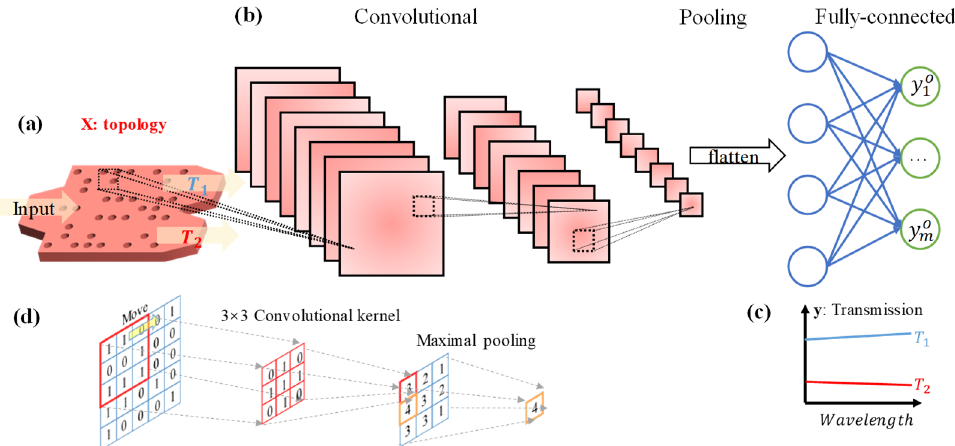
Figure 7. Training of a CNN to predict the efficiency of a power splitter based on QR-code like structure. ( a ) Initial QR-code structure with one input waveguide and two output waveguides. ( b ) Schematic process of CNN. ( c ) Optical performance of power splitter. ( d ) A simple example of convolutional and max pooling operations.